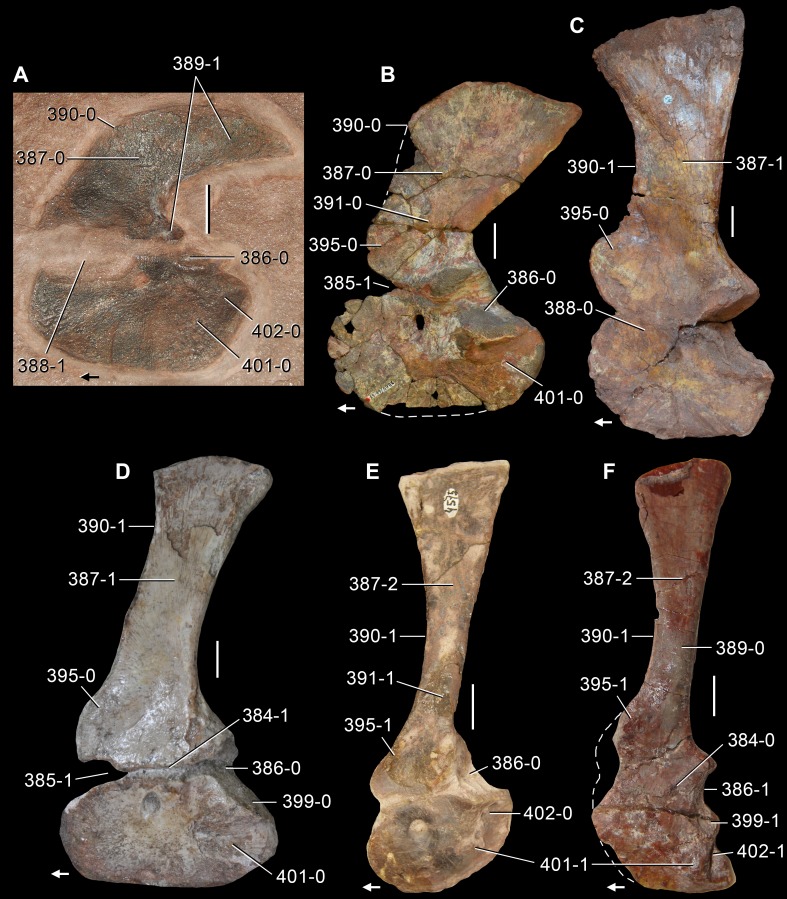
Scapulae and coracoids of Triassic archosauromorphs in lateral view.(A) Amotosaurus rotfeldensis (SMNS 50830); (B) Sarmatosuchus otschevi (PIN 2865/68-37); (C) Garjainia prima (PIN 2394/5-32); (D) Euparkeria capensis (SAM-PK-5867, mirrored); (E) Chanaresuchus bonapartei (PVL 4575); and (F) Lewisuchus admixtus (PULR 01, mirrored). Numbers indicate character-states scored in the data matrix and the arrows indicate anterior direction. Scale bars equal 5 mm in (A, D, F), 2 cm in (B, C), and 1 cm in (E).